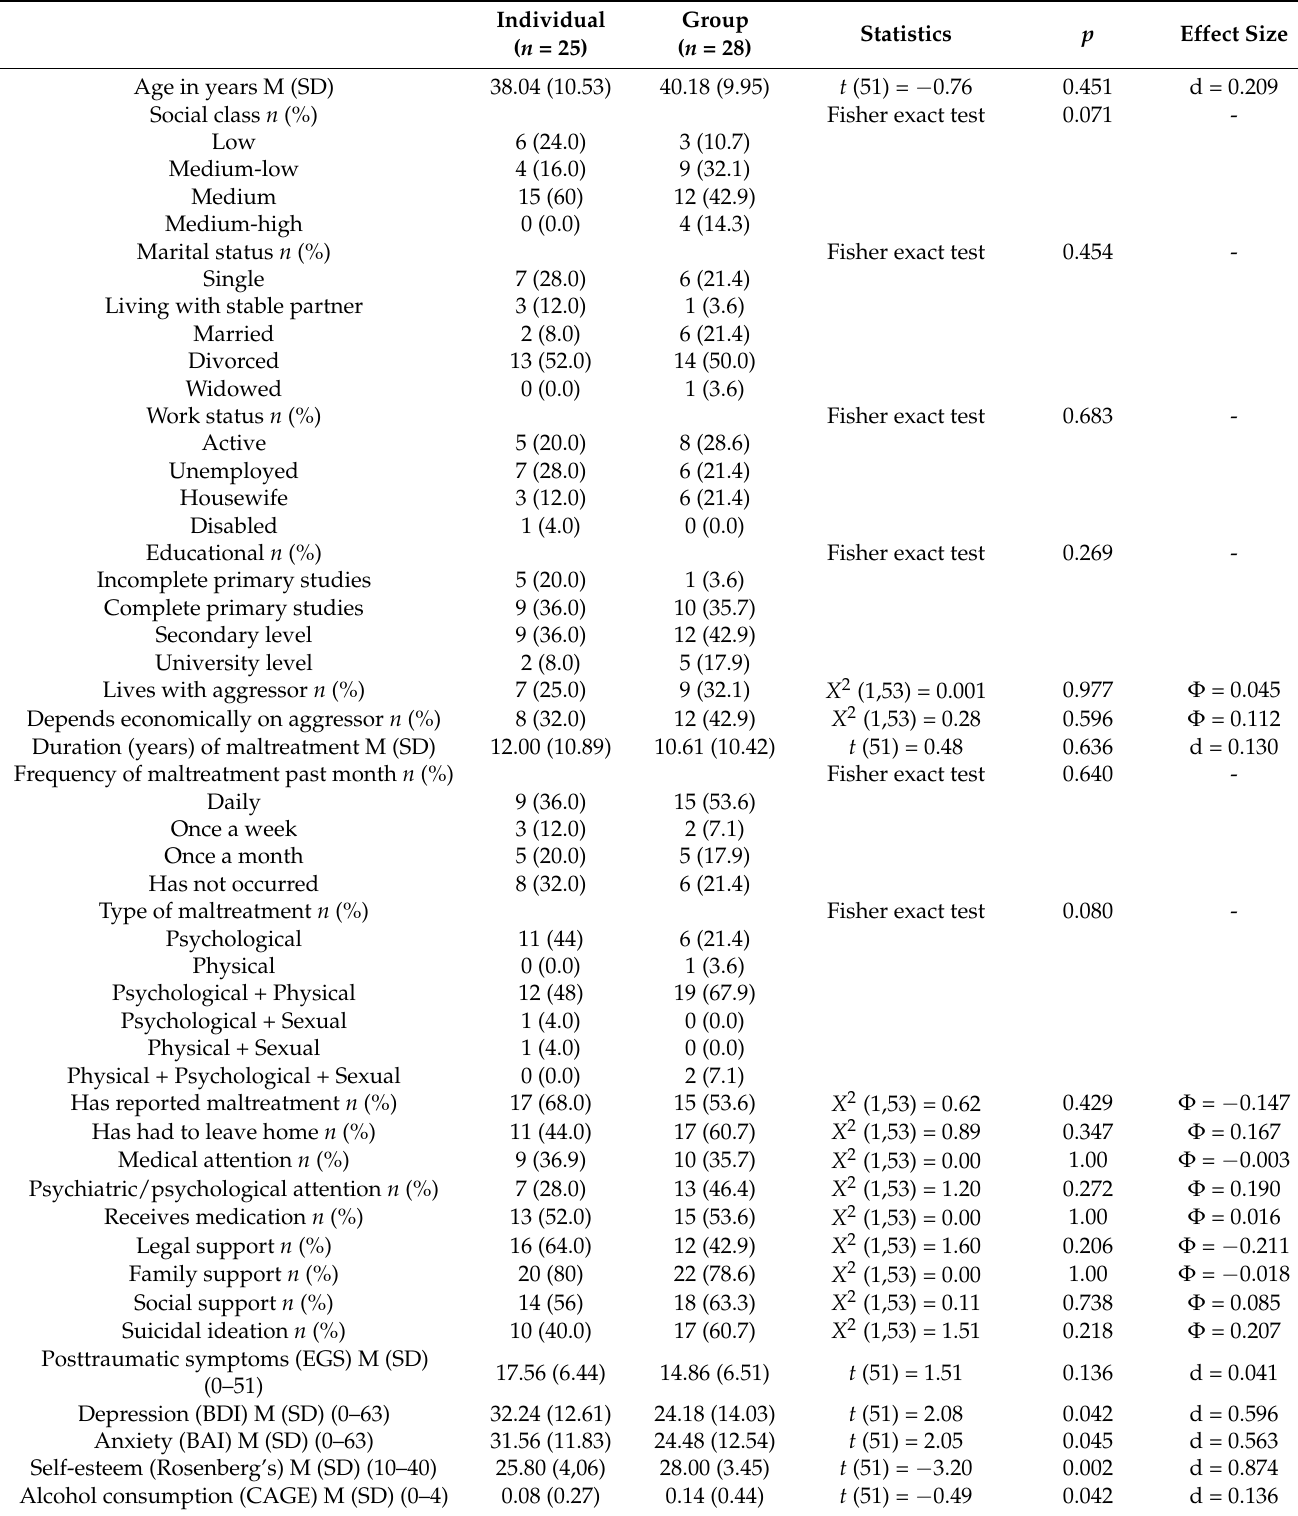
Table 1. Characteristics of women, violence situation, emotional status, and groups homogeneity at baseline ( n =